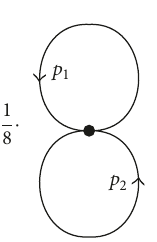
Figure 6: The two-loop diagram for the pressure in the massive sec- tor of deconfining SU(2) Yang-Mills thermodynamics (symmetry factor 1/8